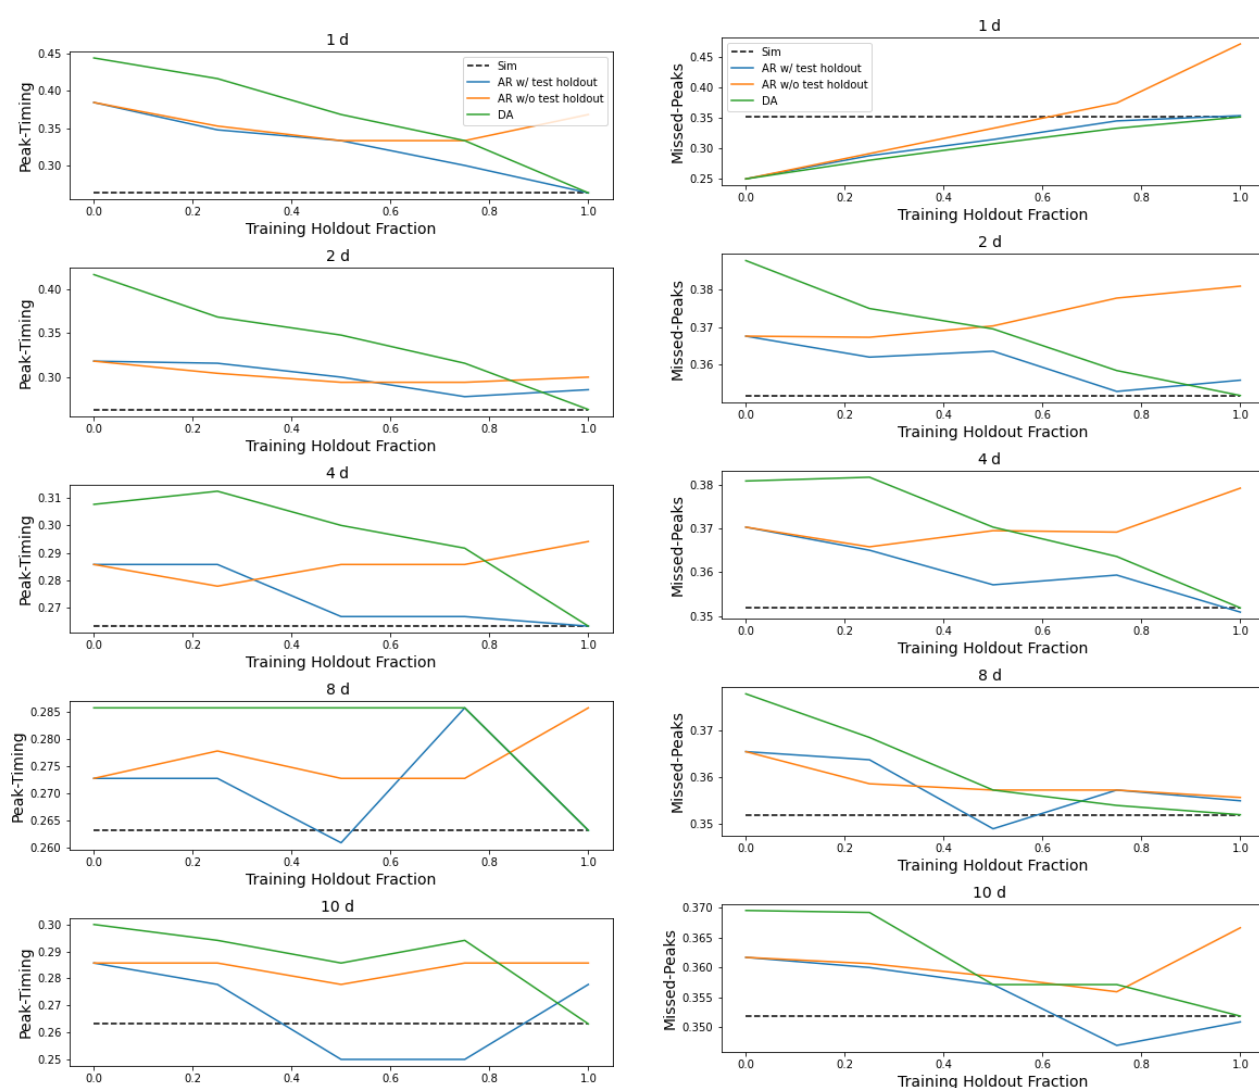
Figure H5. Same as Fig. 4 but for peak timing error (Appendix E).